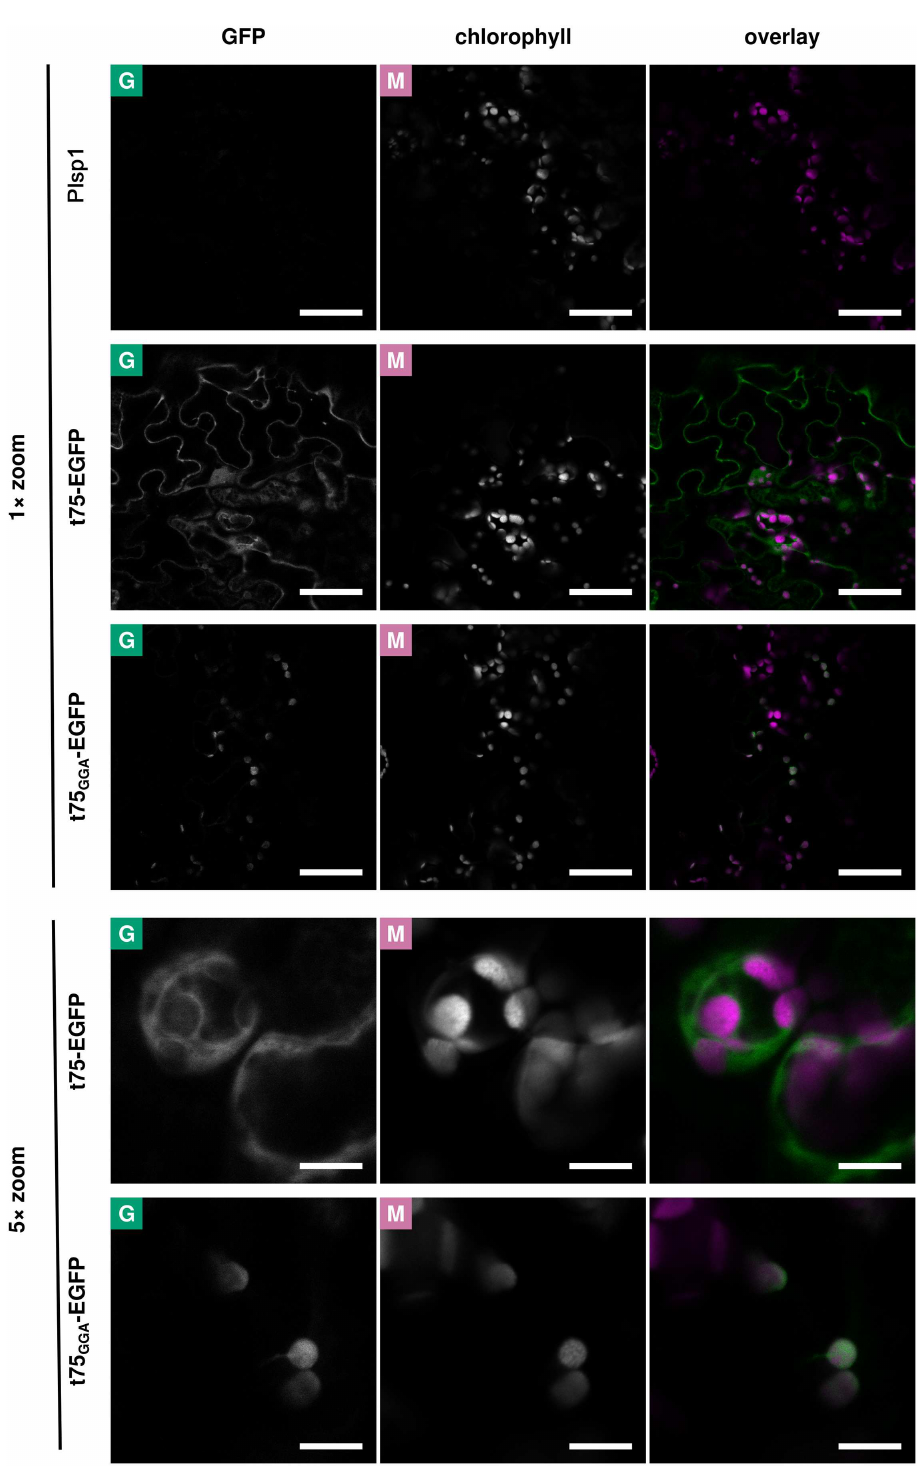
Fig 4. Confocal microscopy analysis of t75-EGFP variants after transient expression in N . benthamiana . Leaves of N . benthamiana were agroinfiltrated with constructs encoding Plsp1 (non- fluorescent control), t75-EGFP, or t75 GGA -EGFP. Fluorescence from EGFP and chlorophyllwas observedin infiltrated leaves by confocalmicroscopy. In the overlay, signals from the GFP and chlorophyll channels are depictedas green and magenta, respectively. Scale bars represent 50 μ m (1 × zoom) or 10 μ m (5 × zoom). See S4–S6Figs for additionalsets of images.